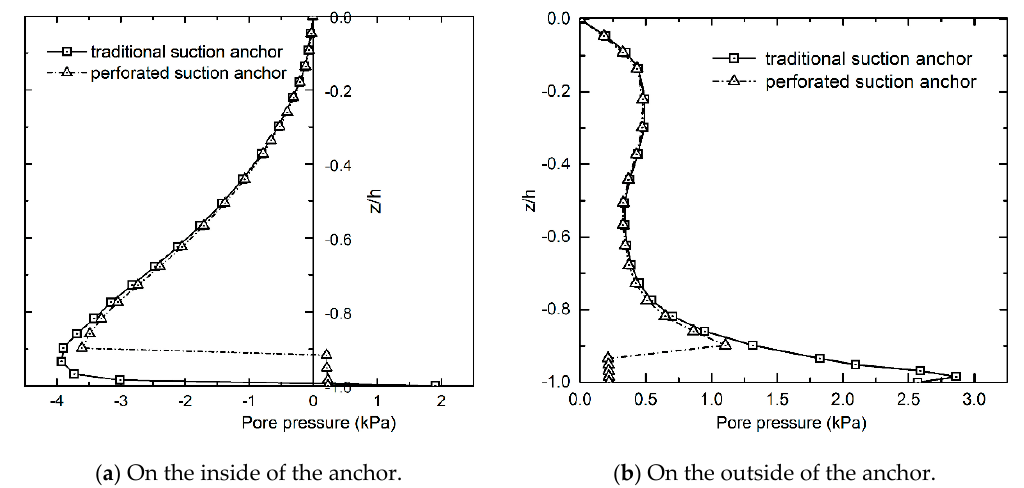
( a ) On the inside of the anchor. ( b ) On the outside of the anchor. Figure 16. Comparison of residual pore pressure distribution between the traditional anchor and the perforated anchor. perforated